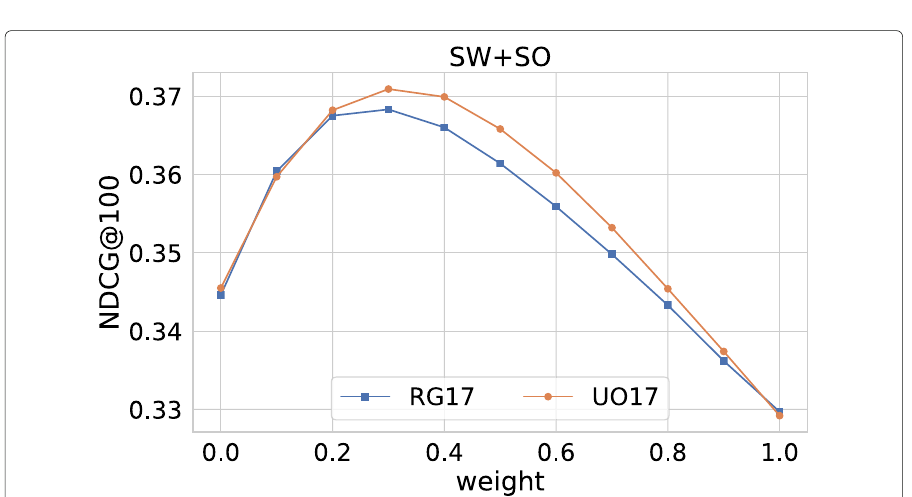
Fig. 12 Global mean performance of the combination of SW and SO with respect to the weight of SO. The combined model (SW+SO) has superior performance with the optimal weight